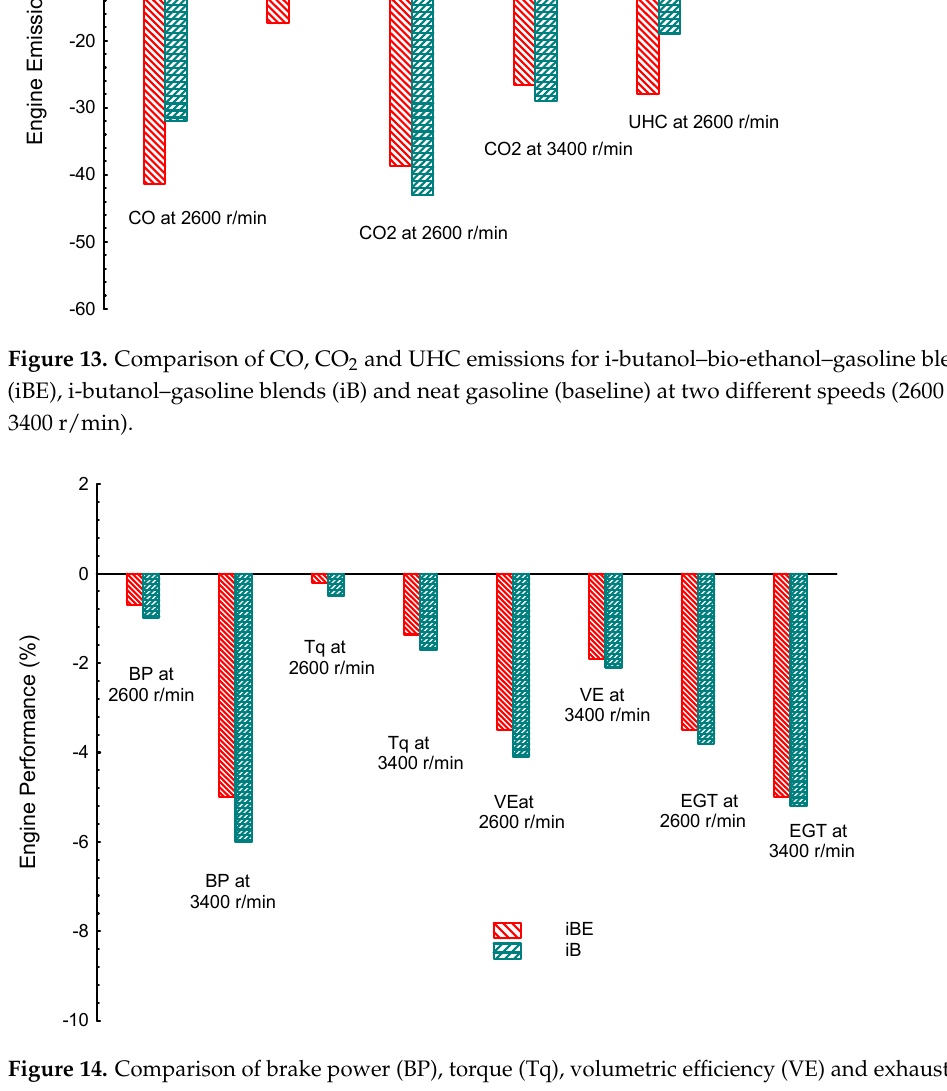
Figure 14. Comparison of brake power (BP), torque (Tq), volumetric efficiency (VE) and exhaust gas temperature (EGT) for i-butanol–bio-ethanol–gasoline blends (iBE), i-butanol–gasoline blends (iB) and neat gasoline (baseline) at two different speeds (2600 and 3400 r/min). Table 2. Performance and emissions of single and dual alcohol blends.